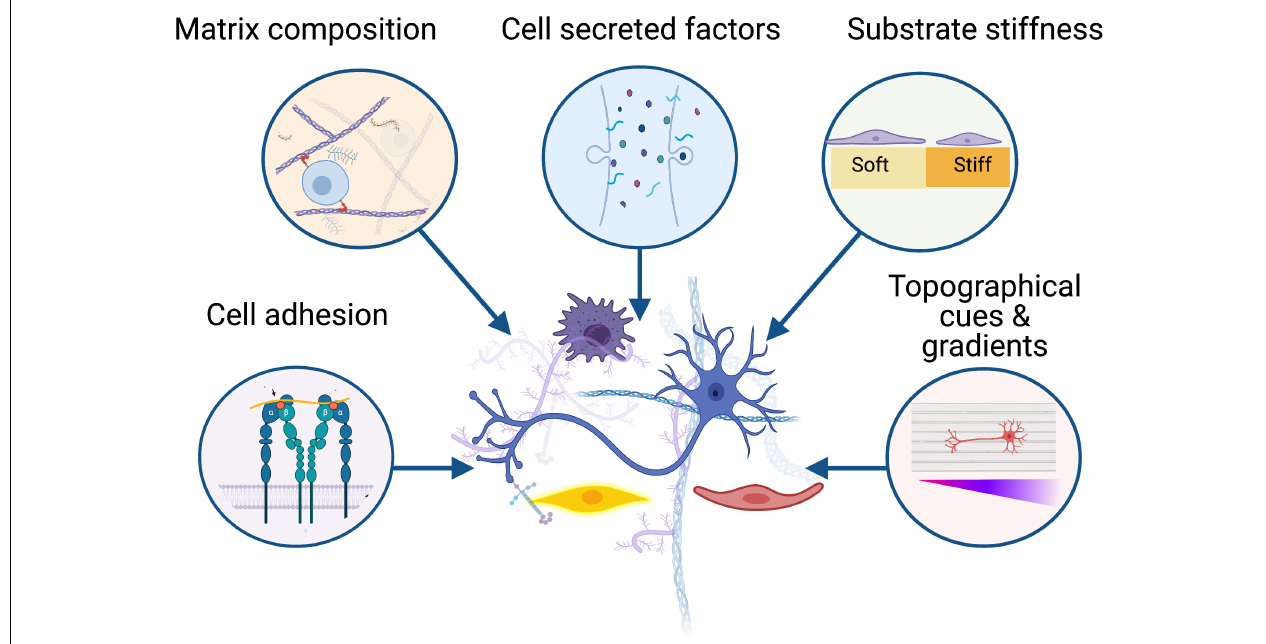
FIGURE 1 | Biomaterials influence the behaviour of key cellular players in peripheral nerve regeneration including neurons, Schwann cells, immune cells, and vasculature. Successful regeneration is dependent on the interactions between these cells and the surrounding microenvironment, from cell adhesion to substrate stiffness, growth factors, and topographical gradients. Created with